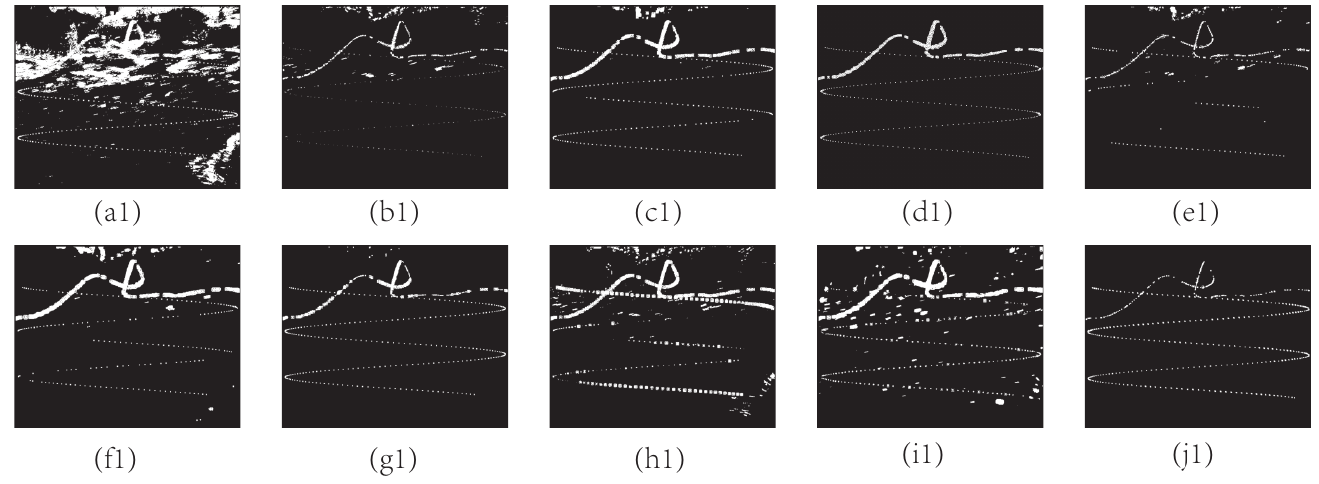
Figure 12. Panels ( a1 – j1 ) shows the detection results of sequence A of top hat, ANI, PSTNN, ASTTV, GST, NTFRA, NRAM, HB-MLCM, ADMD, and the proposed